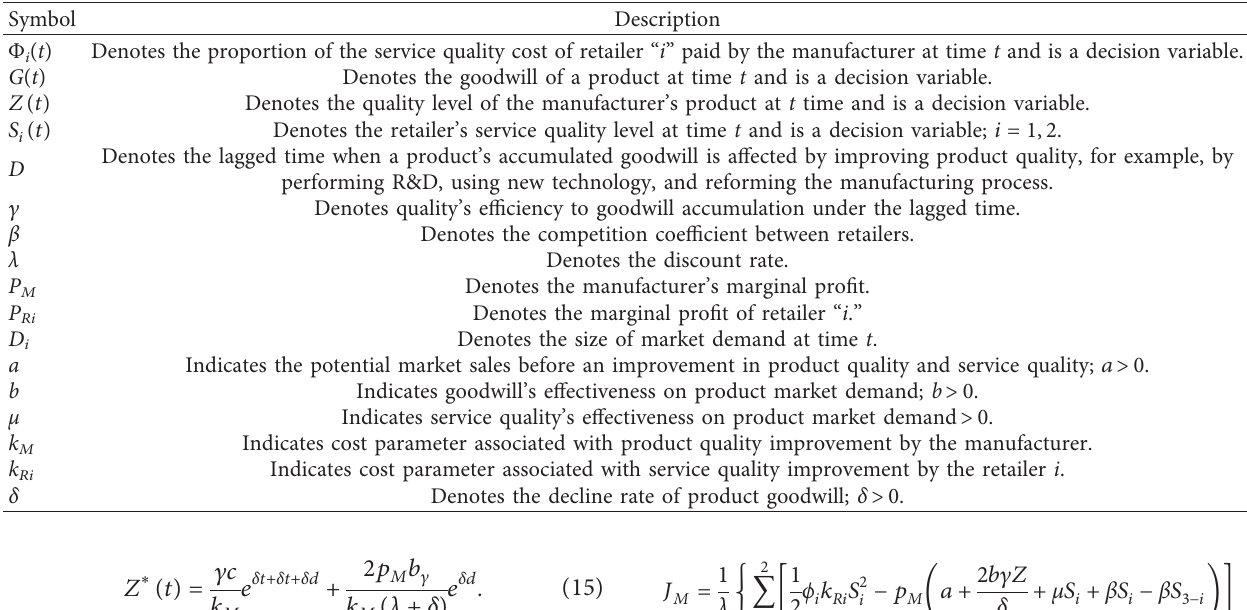
Table 1: Symbols and